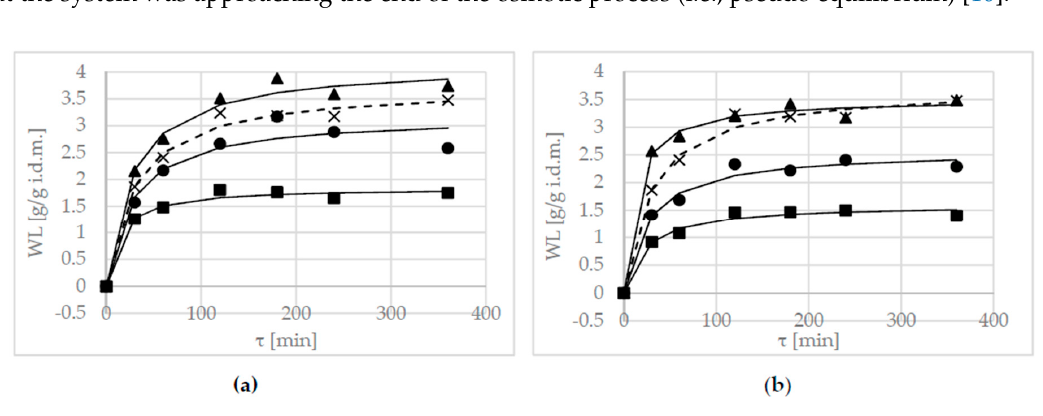
Table 3. The influence of osmotic pre-treatment in different solution types, concentrations, and times, on the water content (g/g d.m.) in